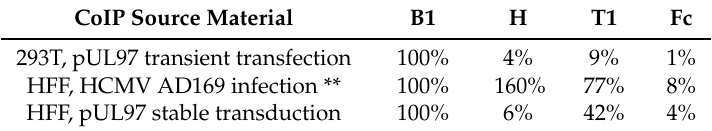
Table 2. Quantities of pUL97 interacting with cyclins derived from three different cell systems *.